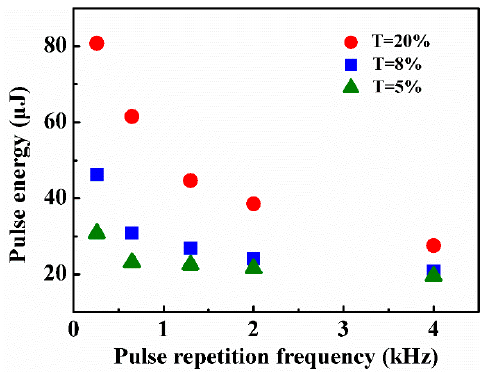
Figure 4. Pulse energy vs. pulse repetition frequency with different output couplers.